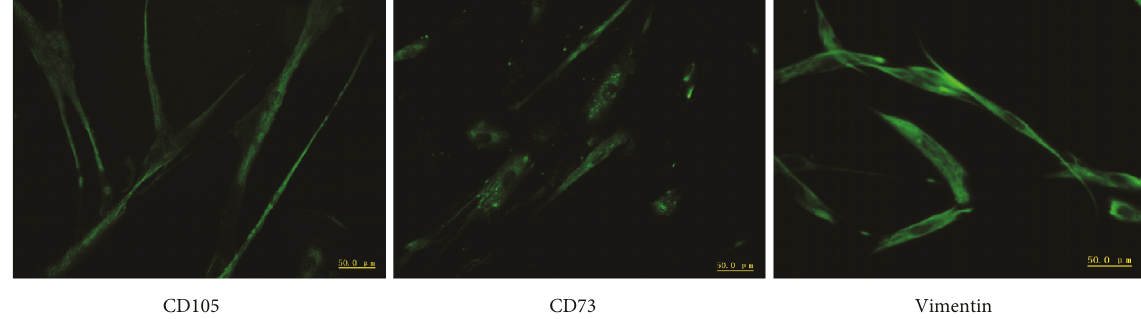
Figure 1: hAMC express stem cell speci fi c markers. Stem cell markers — CD105, CD73, and vimentin — were shown by immuno fl uorescence in hAMC. Magni fi cation: ×